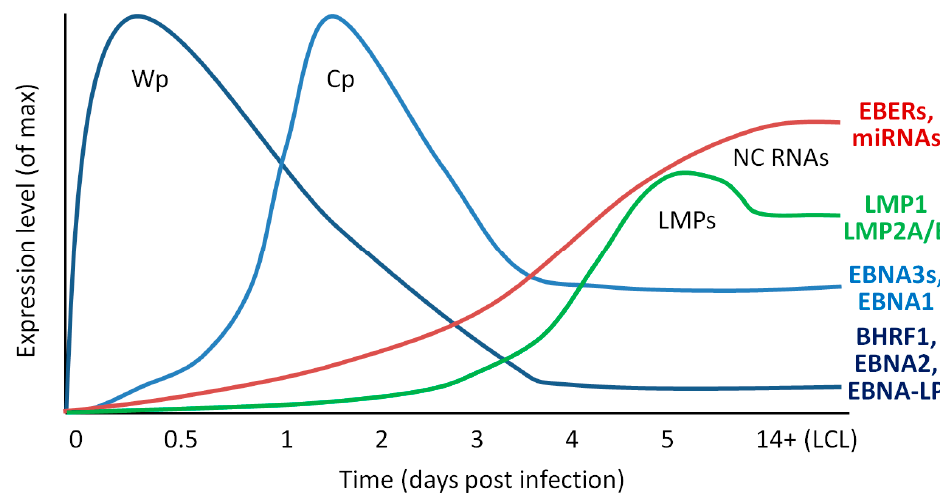
Figure 2. Temporal patterns of latent gene expression during growth transformation of primary resting B cells. Schematic showing the general transcription patterns of different classes of latent EBV genes during in vitro growth transformation of primary, resting B cells. Wp-derived transcripts preferentially give rise to BHRF1, EBNA2 and EBNA-LP in order to kick start cells into cycle, though they also encode EBNA-3A, -3B and -3C (EBNA3s) and EBNA1. Cp can encode all EBNAs and BHRF1. NC RNAs include EBER1, EBER2, miR-BARTs and miR-BHRF1s. Data are cumulative estimations based on transcriptional data published by Tierney et al. [33], Shannon-Lowe et al. [30], and Amoroso et al. [24].